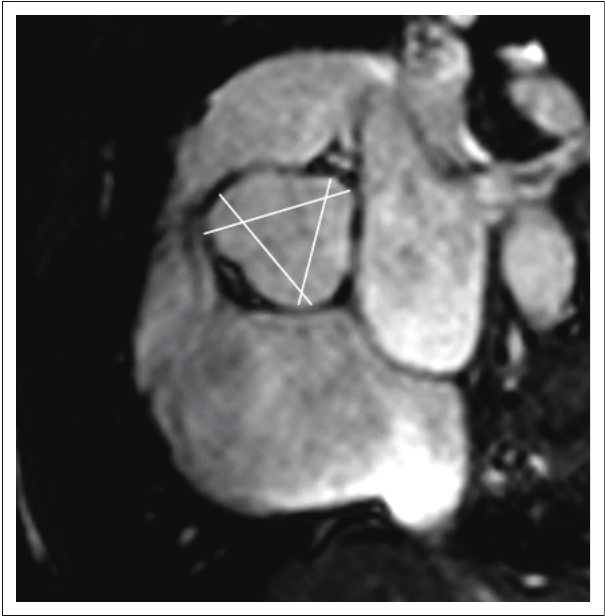
FIGURE 16: Axial cine SSFP image through the aortic valve. One of the methods of measuring the aortic valve is to measure the maximum diameters between the adjacent sinus of Valsalva (white lines) sinus-to-sinus measurement.